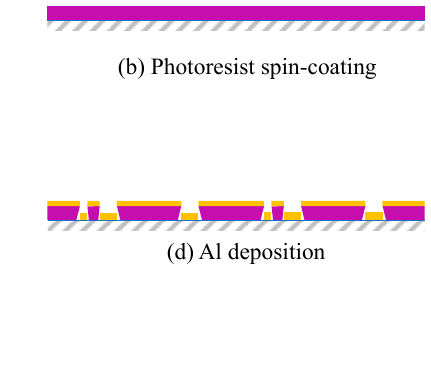
Figure 6. Test device configuration with ( a ) transducers face-to-face and ( b ) transducers back-to- back.